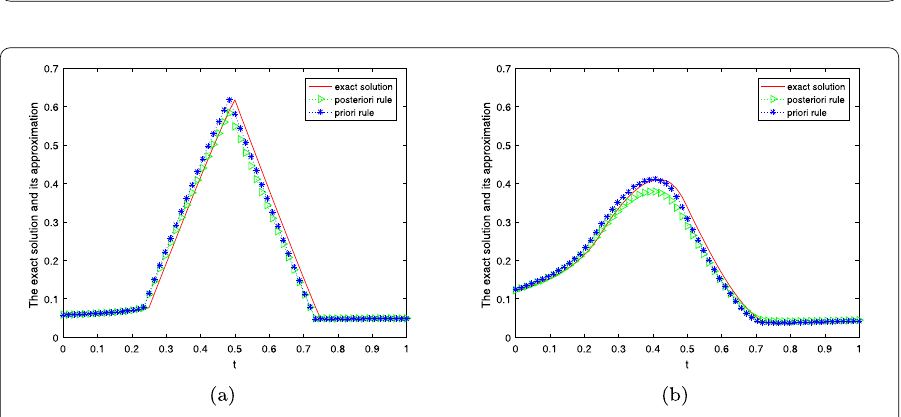
Figure 3 The comparison of the exact solution and its approximation solution for (cid:13) = 0.001 at x = 0.8 with Example 5.2, ( a ) α = 0.1, ( b ) α =